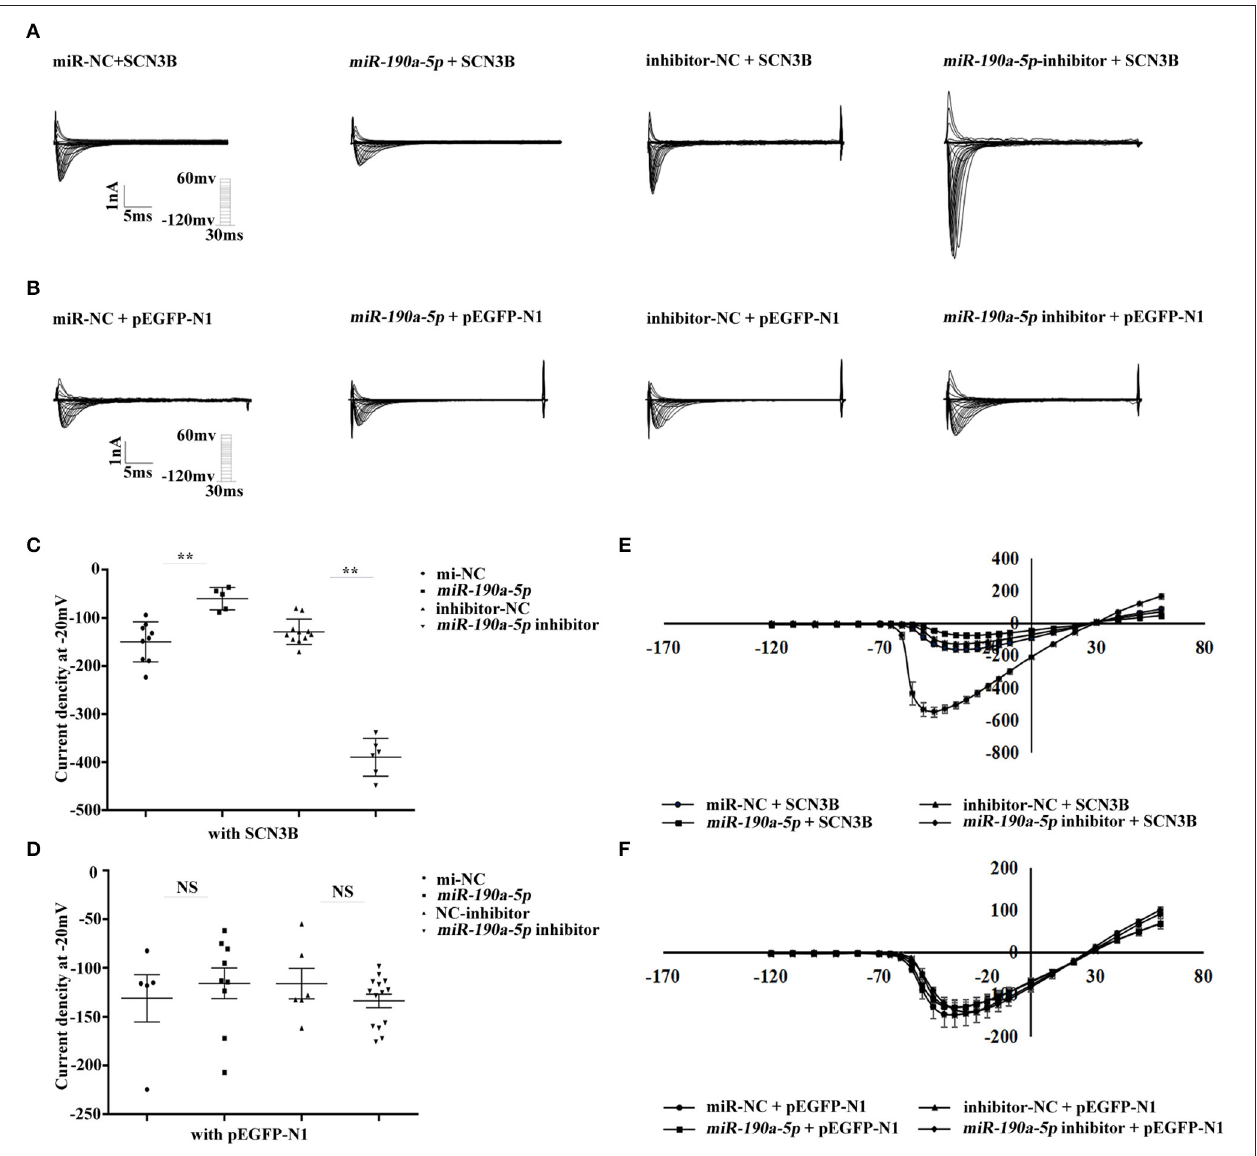
FIGURE 2 | miR-190a-5p reduced the sodium current density of SCN3B. (A,C,E) Representative traces of sodium currents, histogram of sodium current densities at − 20mV, and IV relation for peak sodium current Nav1.5 from HEK293/Nav1.5 cells, respectively, transfected with: (1) miR-NC + SCN3B, (2) miR-190a-5p + SCN3B, (3) inhibitor-NC + SCN3B, and (4) miR-190a-5p inhibitor + SCN3B (** p < 0.01 vs . miR-NC, ** p < 0.01 vs . inhibitor-NC). Data are represented as means ± SEM. (B,D,F) Representative traces of sodium currents, histogram of sodium current densities at − 20mV, and IV relation for peak sodium current Nav1.5 from HEK293/Nav1.5 cells, respectively, transfected with: (1) miR-NC + pEGFP-N1, (2) miR-190a-5p + pEGFP-N1, (3) inhibitor-NC + pEGFP-N1, and (4) miR-190a-5p inhibitor + pEGFP-N1 (NS, no significant difference vs . miR-NC, NS vs . inhibitor-NC). Data are represented as means ± SEM.